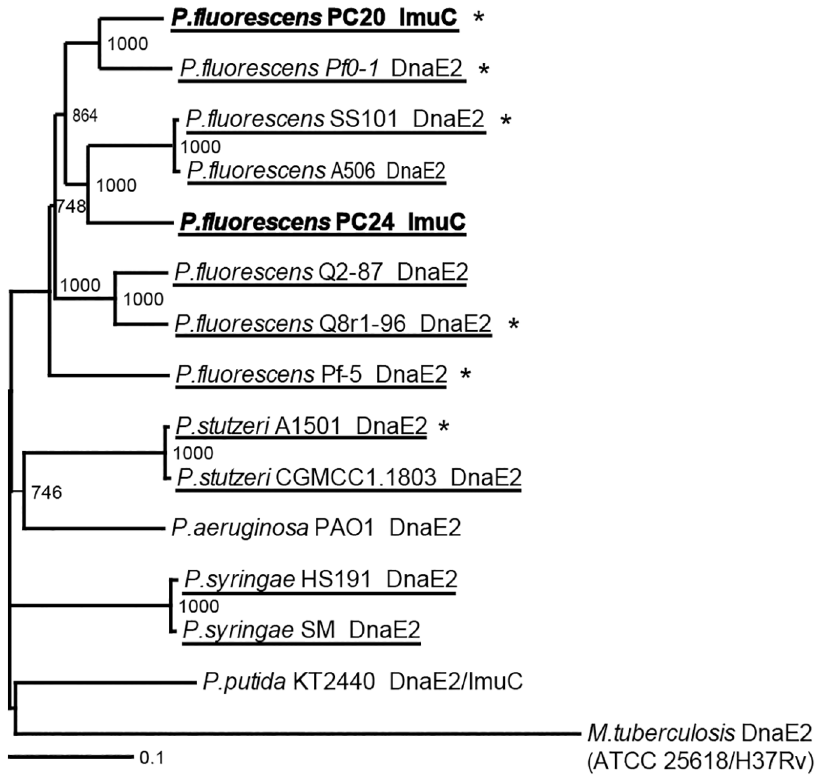
Fig 4. The phylogenetic tree of ImuC/DnaE2 protein sequences. The underlinedproteinsare from strains possessing rulAB genesand the ones marked with star are from strains where rulAB genes are locatedin the chromosome. Sequences derived from P . fluorescens strains PC20 and PC24 are shown in boldface. Sequences were alignedwith ClustalX2and further visualisedwith TreeViewX. Numbers at branchnodes indicatebootstrappingvalues for 1000 bootstrapreplicates. Values under 500 were removed. The identifiers of the alignedsequencesare presentedin S7 Table.